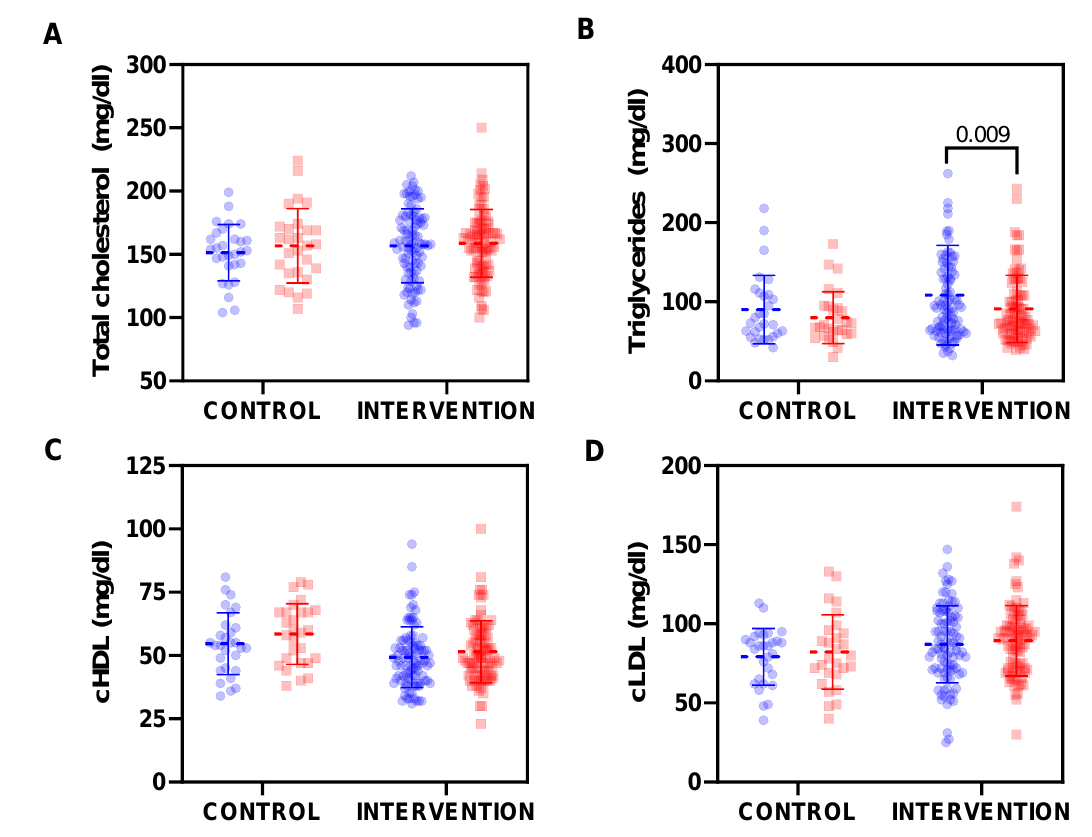
Figure 2. Changes on lipid metabolism parameters: ( A ) total cholesterol, ( B ) triglycerides, ( C ) high- density lipoprotein-cholesterol (cHDL) and ( D ) low-density lipoprotein-cholesterol (cLDL) from baseline (blue dots) to the end of the intervention (red dots). The dashed line represents mean value and solid lines represent standard deviation. Statistically significant differences were analysed by a repeated measures ANOVA.